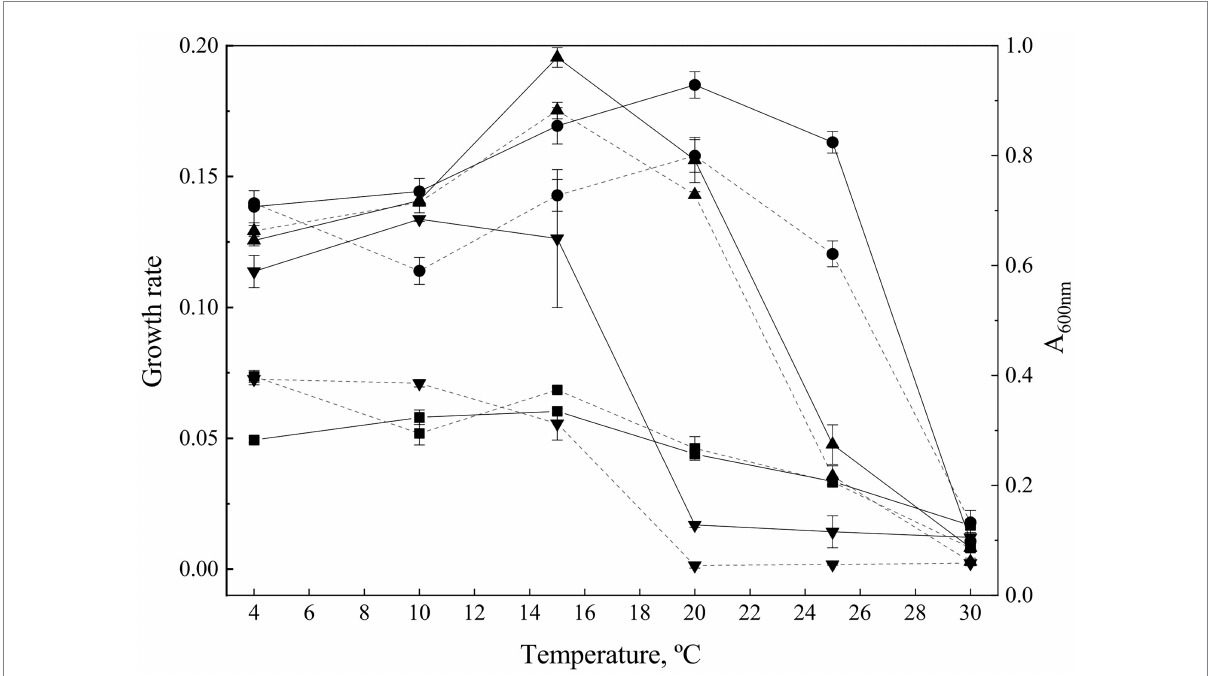
FIGURE 1 Growth parameters. Growth curves were determined at temperatures from 4 ° C to 30 ° C. The growth rate (discontinuous lanes) was calculated from the exponential phase of the growth curves. Continuous lanes show to the maximum A 600 observed during exponential phase at different temperatures and express the optimal temperature for growth for each strain. Goffeauzyma gilvescens (circle), Glaciozyma martinii (down triangle), Naganishia antarctica (square), and Phenoliferia glacialis (up